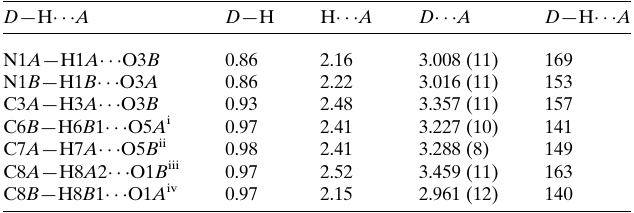
Table 2 Hydrogen-bond geometry (A˚ , (cid:3) ).